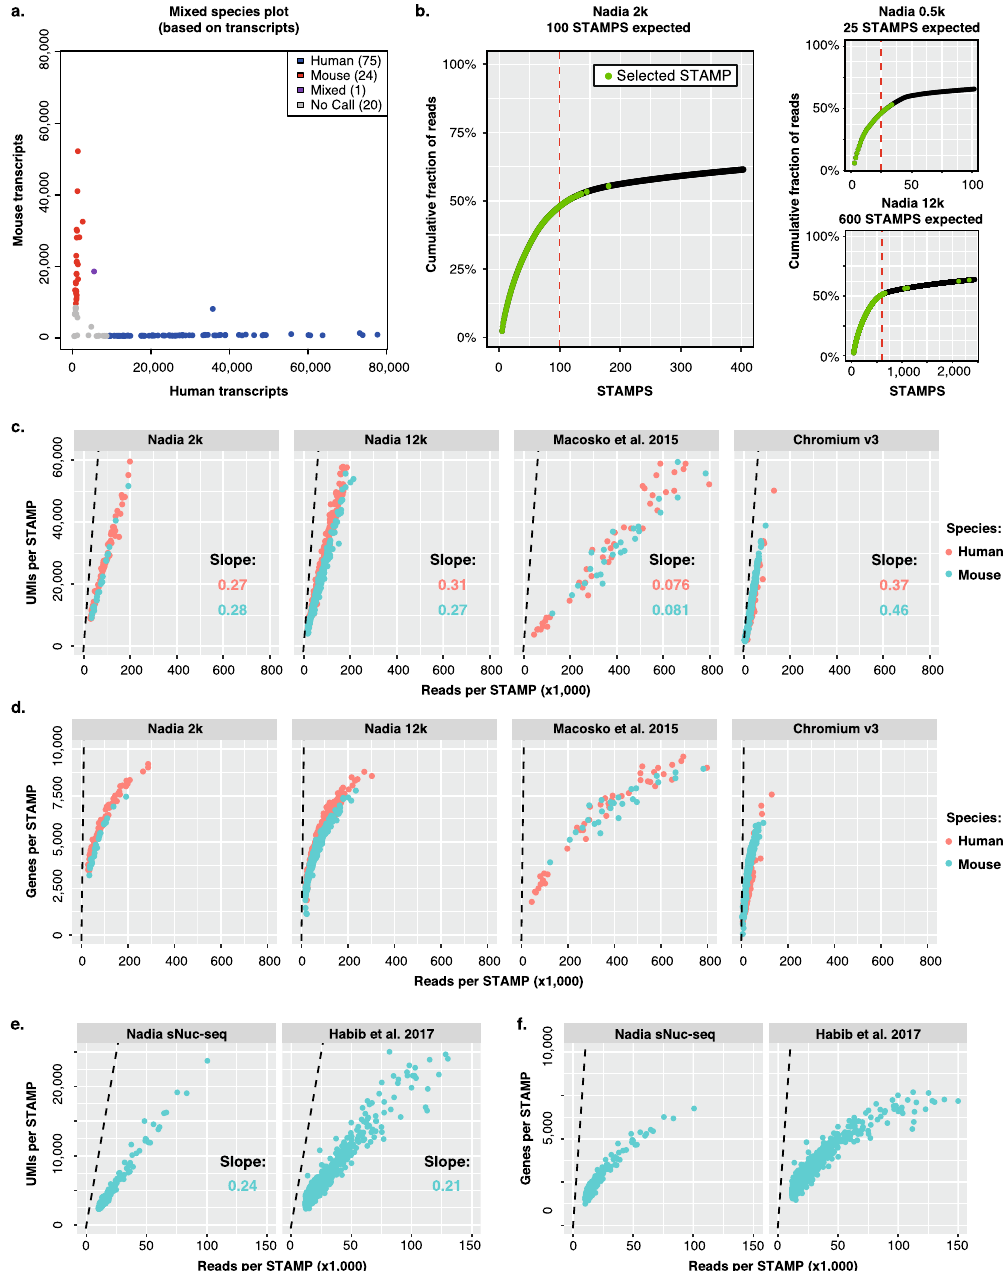
Figure 2. Technical performance for single cell and single nuclei sequencing. ( a ) Mixed species barnyard plot of transcripts after profiling 2,000 collected beads (i.e. 100 expected STAMPs) representing a mix of human HEK293 cells and mouse 3T3 cells input at platform recommended cell loading density of 3 × 10 5 cells per ml. ( b ) Cumulative frequency plots reporting sequencing reads associated with individual barcodes when using indicated starting bead inputs for cDNA library construction. Dashed red lines indicate expected STAMPs for each experiment. Larger panel represents dataset used in ( a ). “Nadia 2k” generated cDNA libraries from 2,000 beads, “Nadia 0.5k” from 500 beads, and “Nadia 12k” from 12,000 beads. ( c ) Number of UMIs detected relative to individual STAMP read counts for indicated mixed-species whole cell experiments (see “Methods” section). “Nadia 2k” profiled 2000 collected beads and expected 100 STAMPs, “Nadia 12k” profiled 12,000 beads and expected 600 STAMPs, “Macosko et al. 9 ” expected 100 STAMPs, “Chromium v3” expected 1400 STAMPs. Dashed line represents maximal point at which each sequencing read would report a unique UMI. ( d ) Same as C but with detected genes reported rather than UMIs. ( e ) Number of UMIs detected relative to individual STAMP read counts for indicated mouse 3T3 experiments (see “Methods” section). Dashed line represents maximal point at which each sequencing read would report a unique UMI. ( f ) Same as E but with detected genes reported rather than